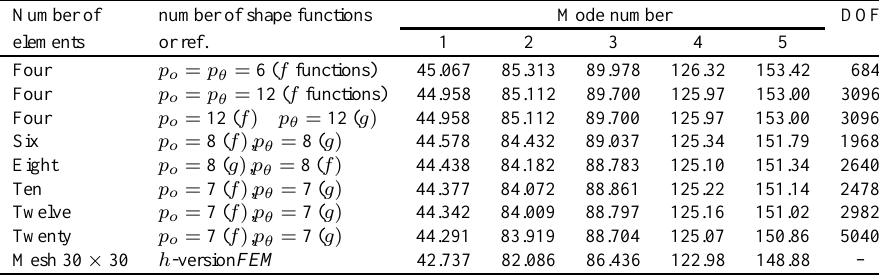
Table 5 First five frequency parameters of a CFCF cylindrical shell a/b = 1, a/R = 1.5, a/h =